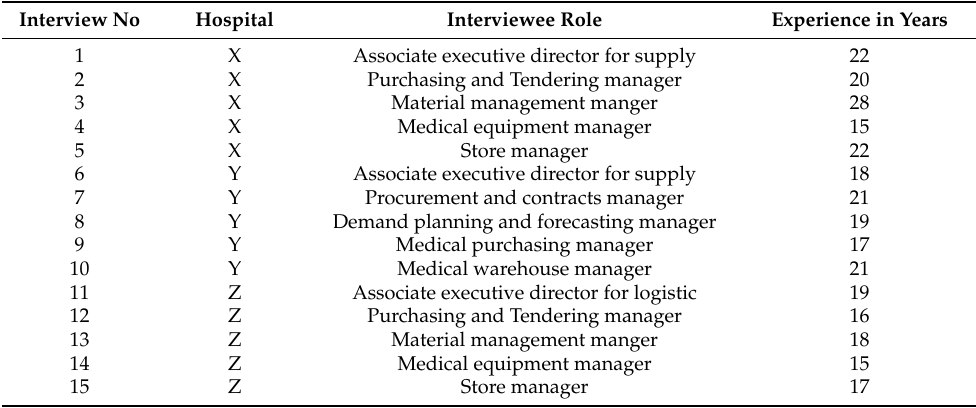
Table 2. Interviewees